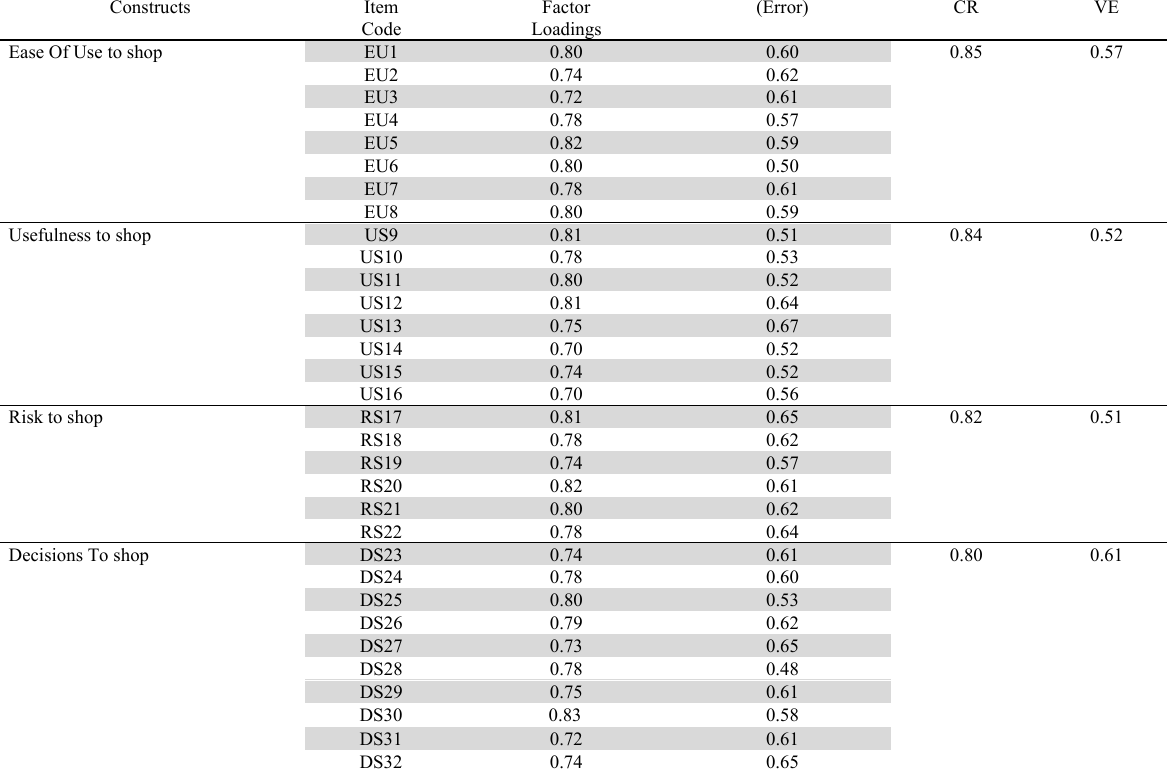
Construct reliability and variance